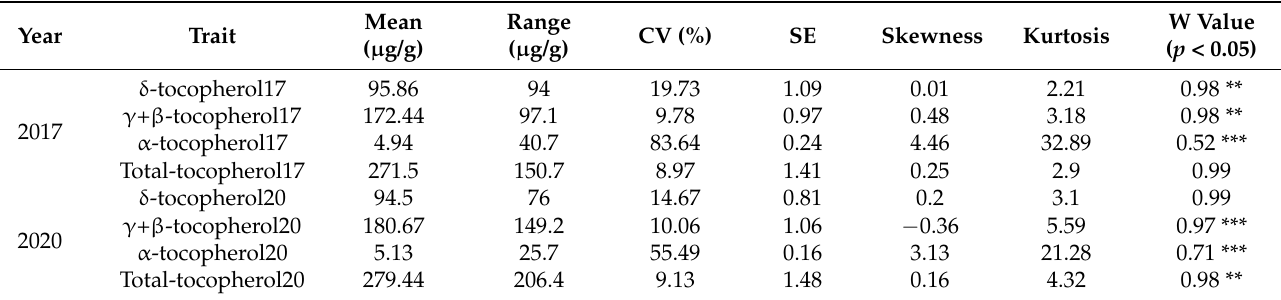
Table 1. Mean, range, CV (%), skewness, kurtosis, and value of Shapiro-Wilk normality test (W value) for seed tocopherol content of the RILs in Carbondale, IL. SE: Standard